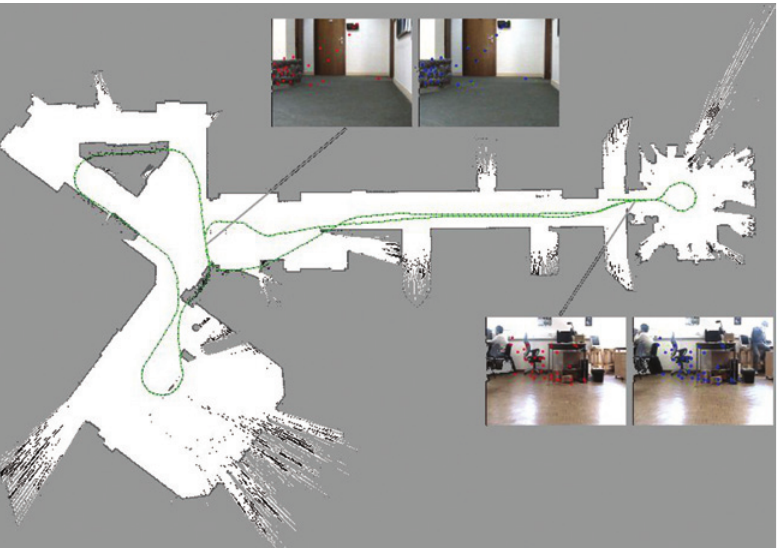
Figure 11. Correction of the Odometry Drift with Loop-Closure Detections. The trajectories have been displayed on the 2D laser SLAM map for reference (“UEI Lab” sequence, 350 images, 7 loop-clo- sures). While the global orientation still shows some drift, the local map structure is coherent and the position of the robot at the end of the trajectory is correctly recognized as the starting